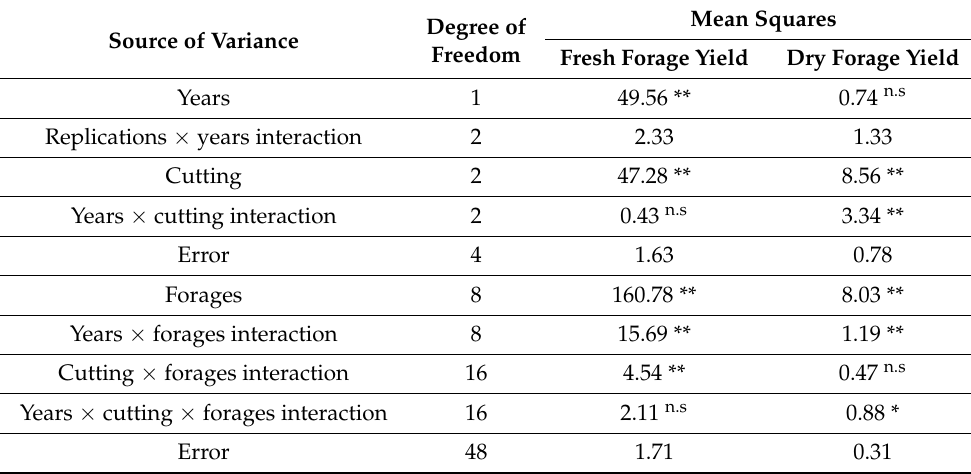
Table 2. Mean squares of fresh and dry forage yields for the studied forages combined over cuttings and years. * p < 0.05, ** p < 0.01, n.s = not